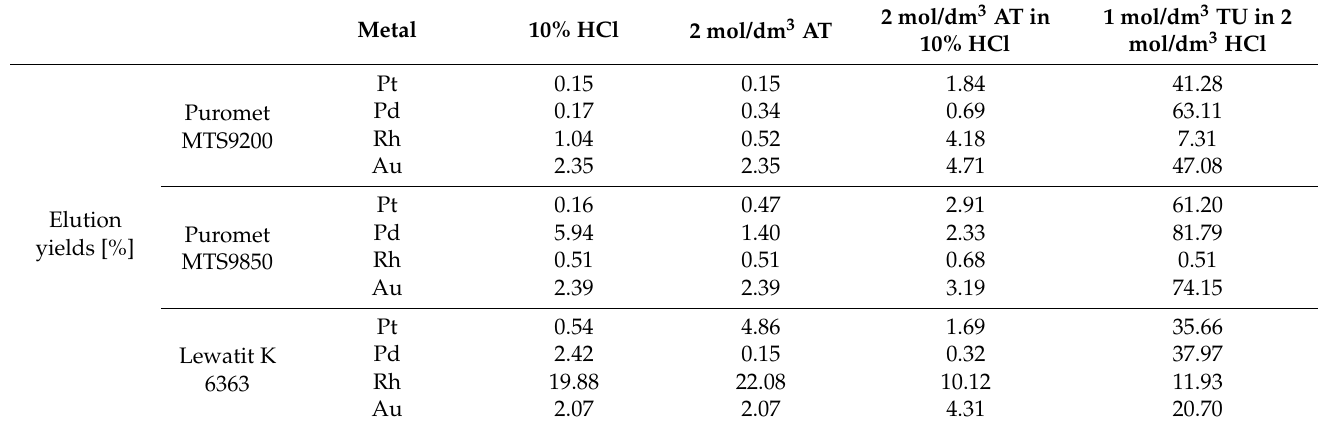
Table 6. Elution yields (AT—ammonium thiocyanate,